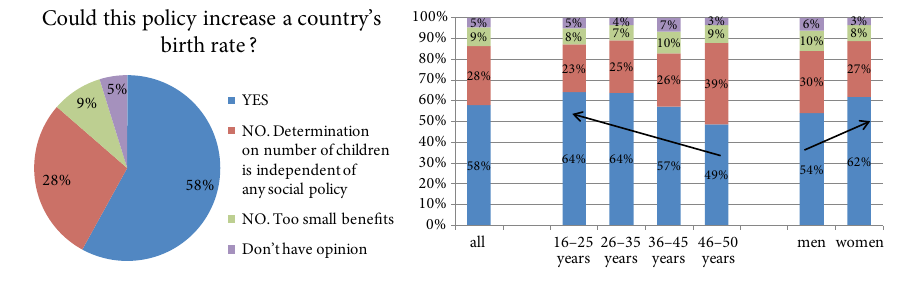
Fig. 13. Respondents’ opinion towards the effect of CDA for birth rate (authorial computation, according to the survey